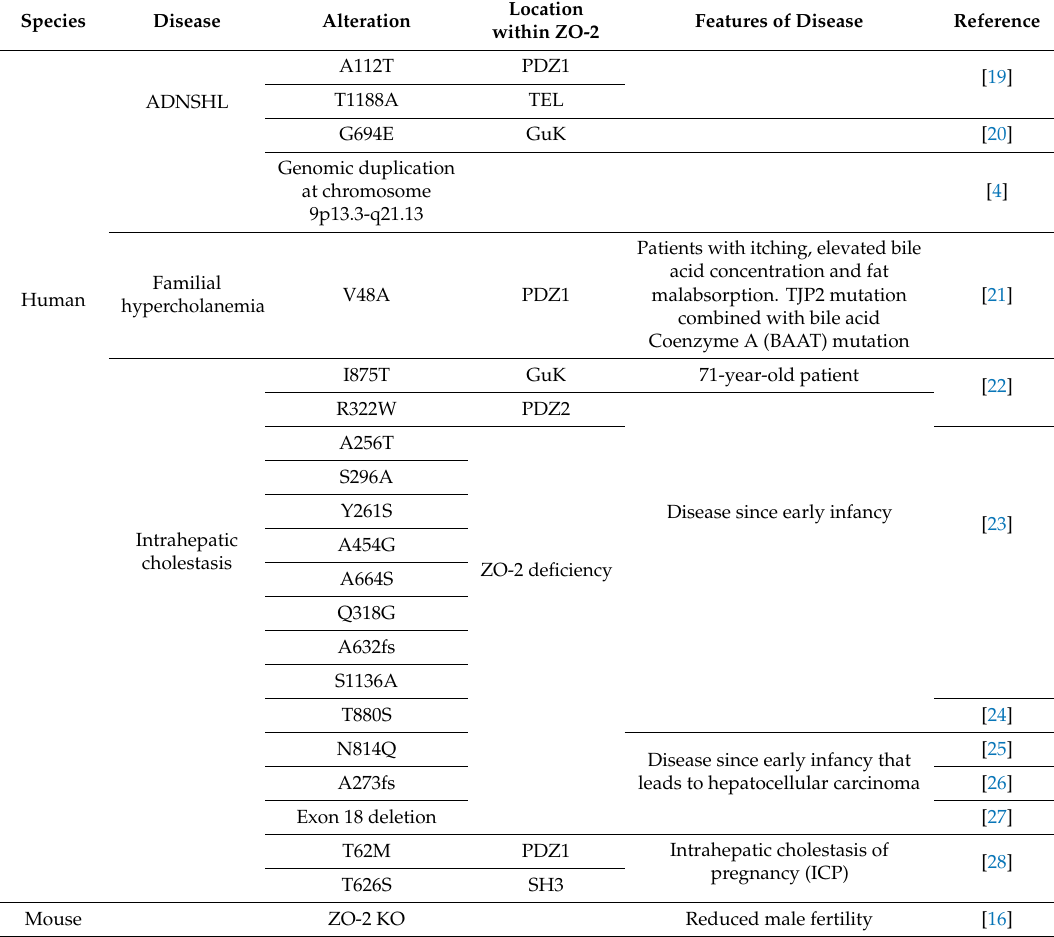
Table 1. ZO-2 mutations and